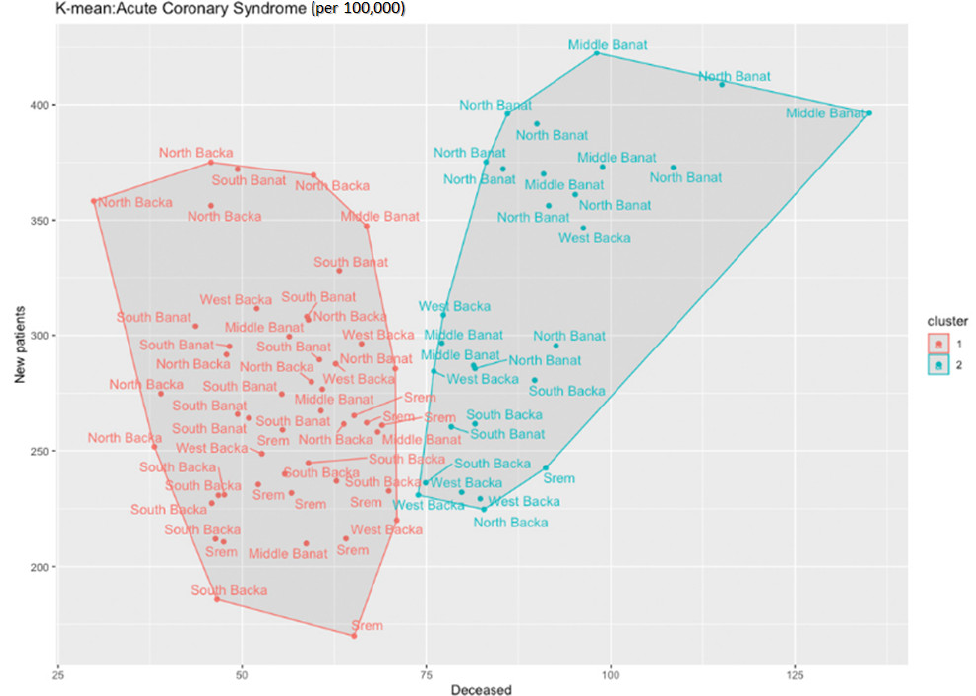
Figure 5. Isolation of two clusters during the analysis of acute coronary syndrome in the researched area.